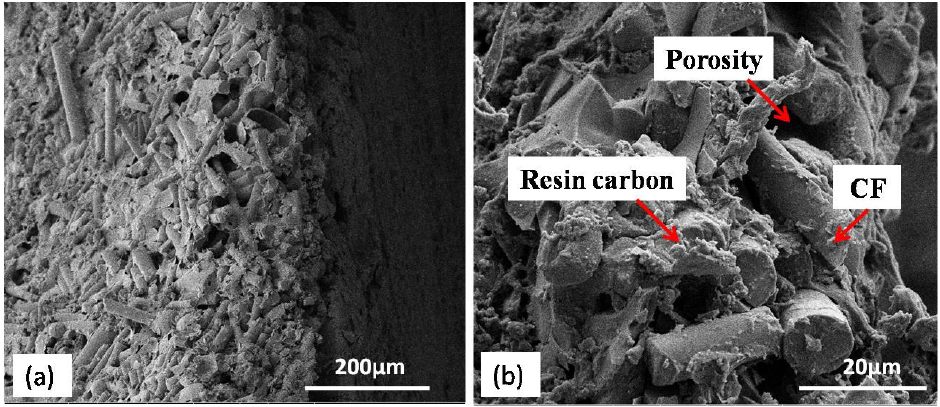
Figure 5. Cross-section of the C/C composite shell: ( a ) Typical structure; ( b ) magnified image.